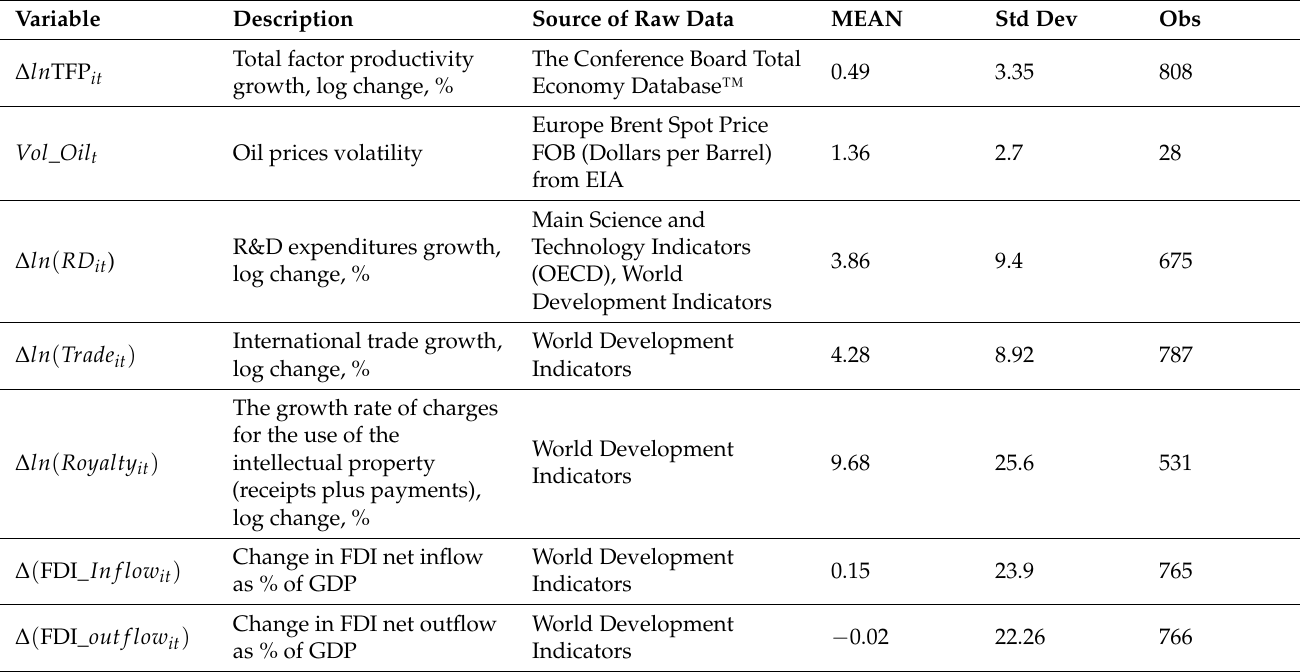
Table 1. Variable’s description and descriptive statistics.